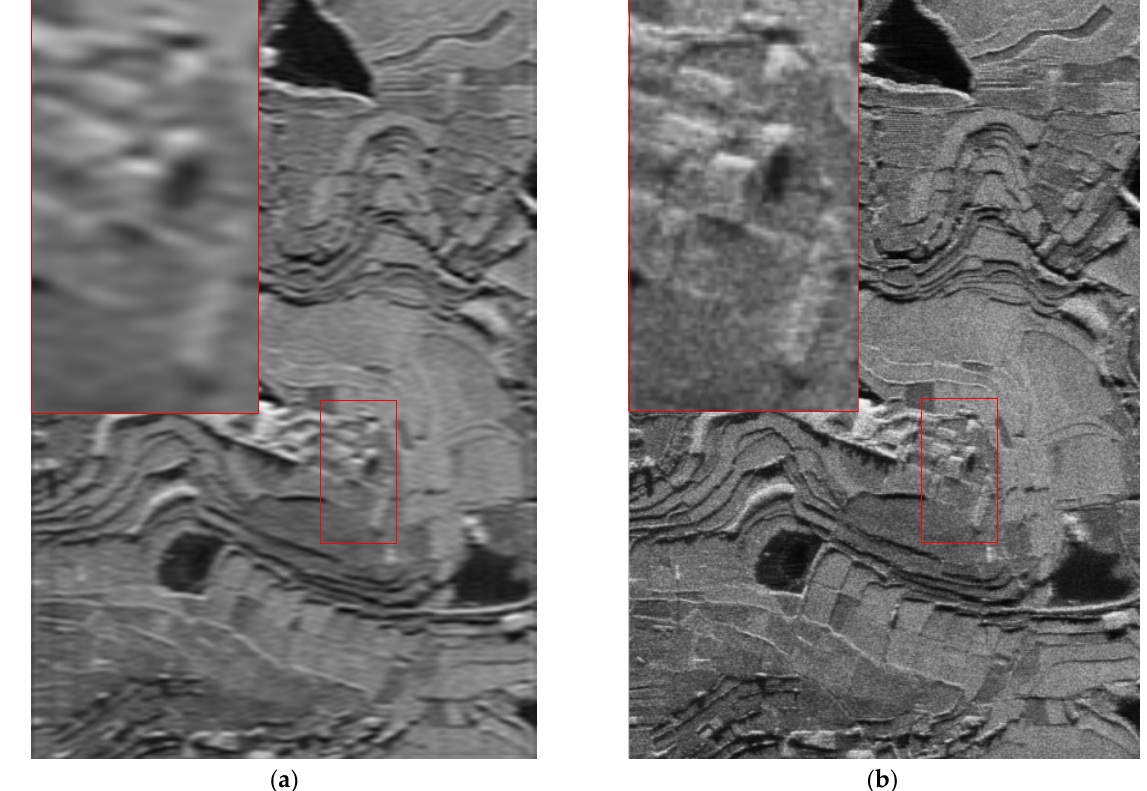
Figure 7. Reconstruction comparison of the real scene. ( a ) RD algorithm. ( b ) Proposed algorithm.